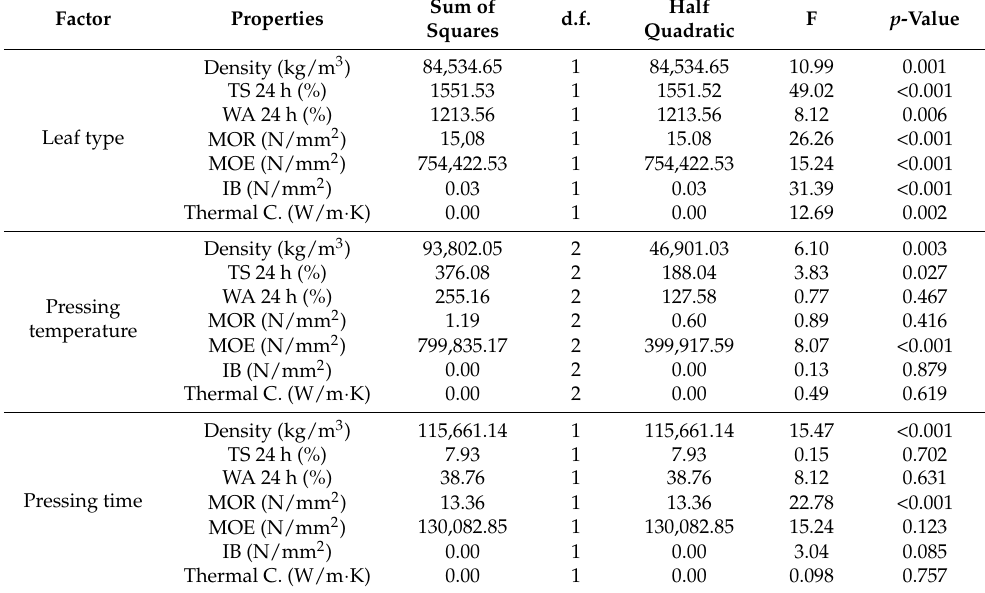
Table 3. ANOVA of the results of the